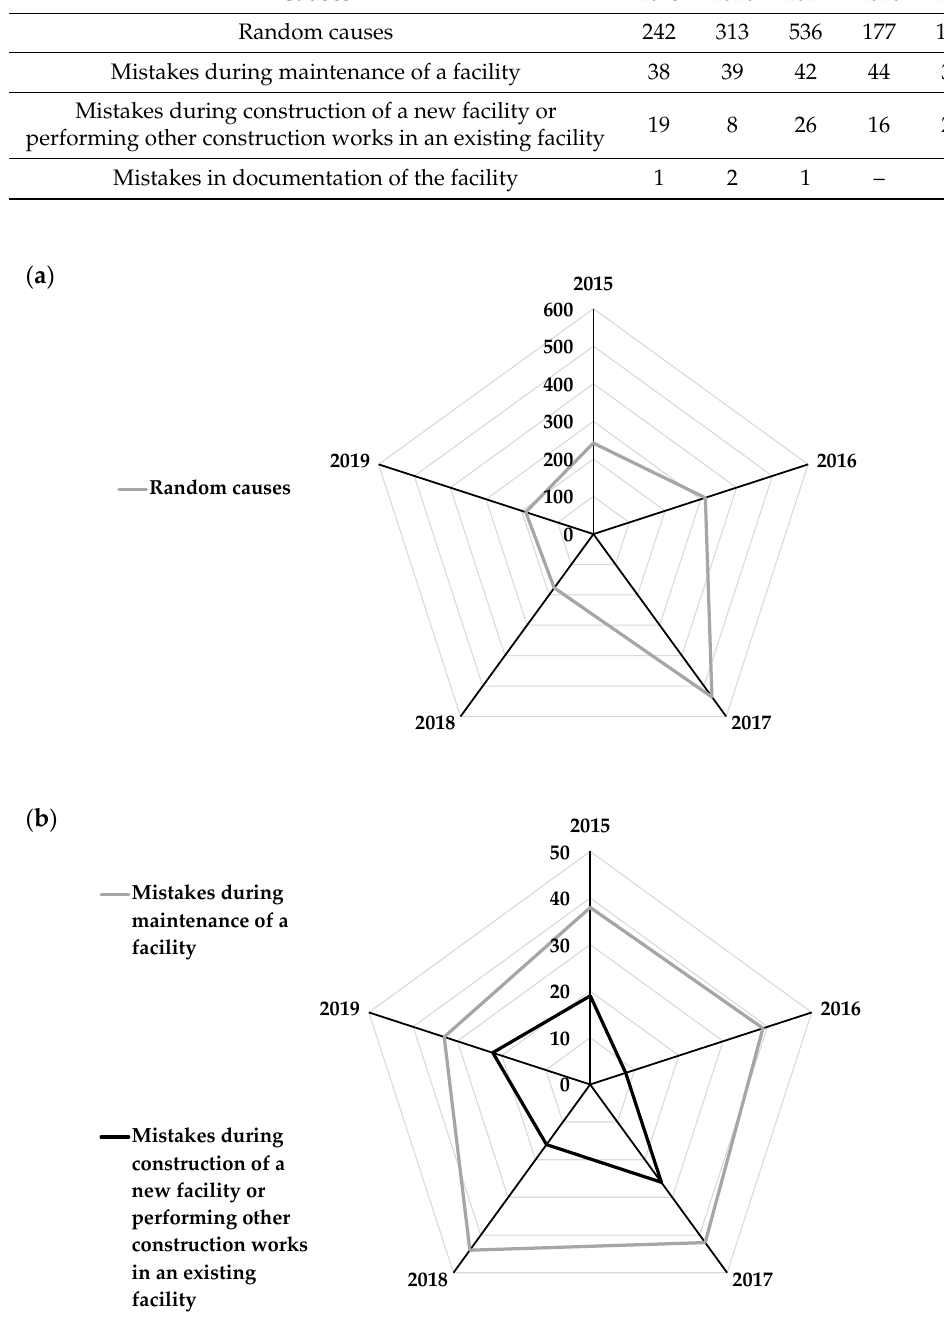
Figure 6. Structure of the causes of structural failures in the period 2015–2019 in Poland ( a ) part 1; ( b ) part 2 (own study).